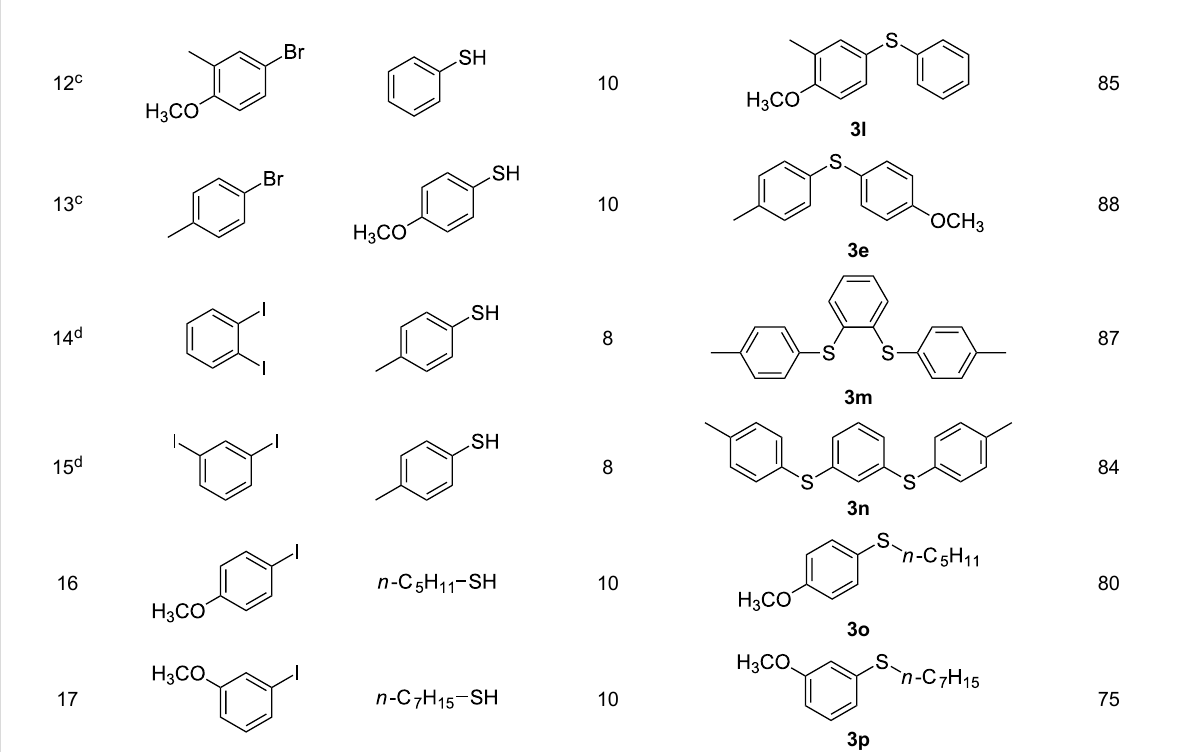
Table 2: Ni/RGO-40 catalyzed C–S cross-coupling between aryl halide and thiol. a (continued)